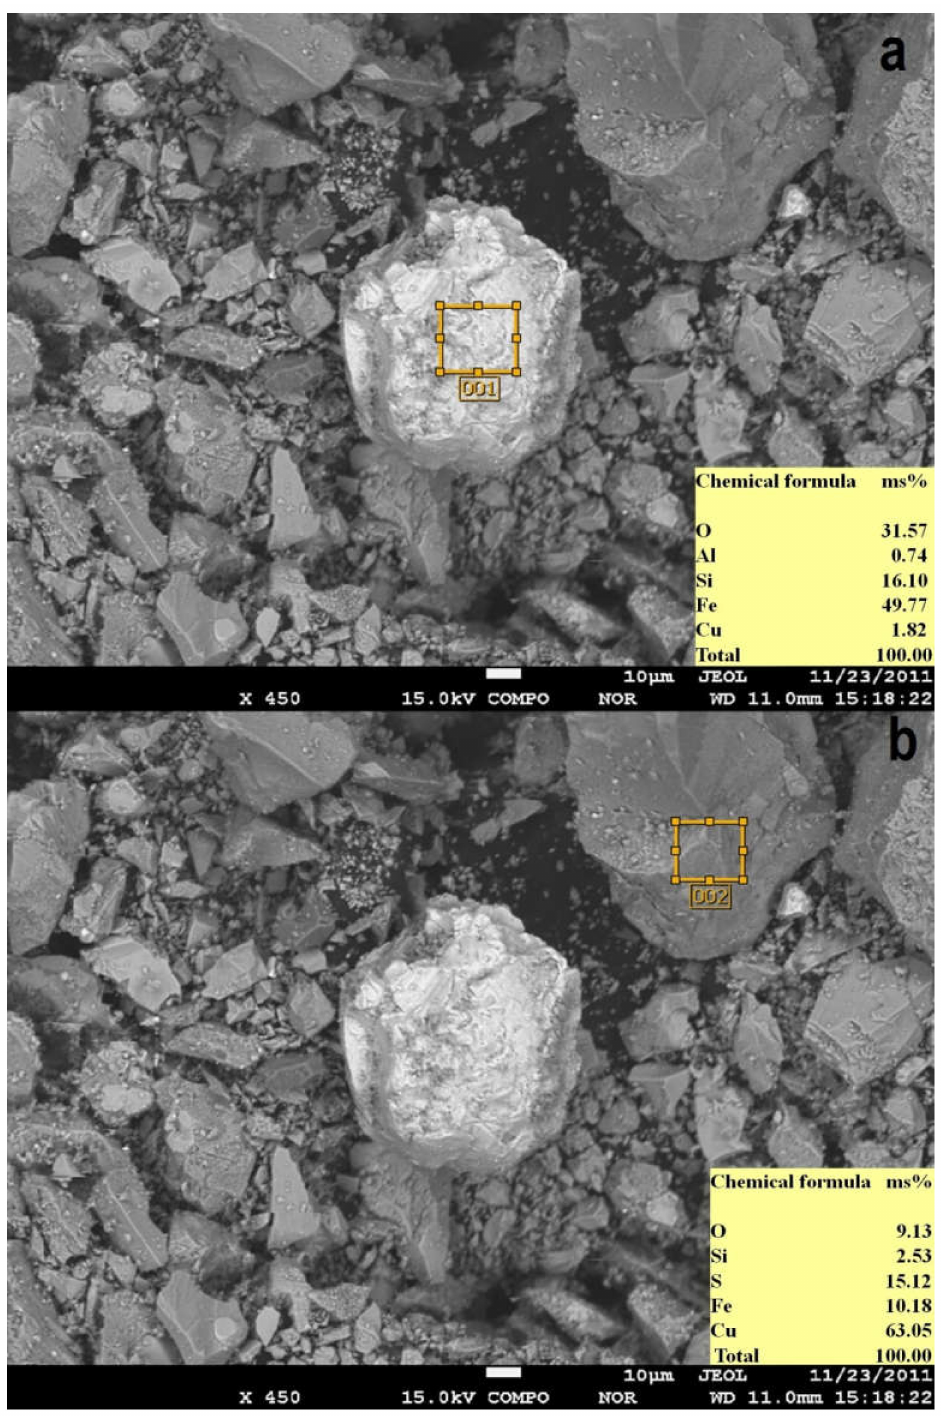
Figure 3. Association of copper in converter slag vis- à -vis the presence in ( a ) oxidic and ( b ) non-oxidic phases (ms%—mass